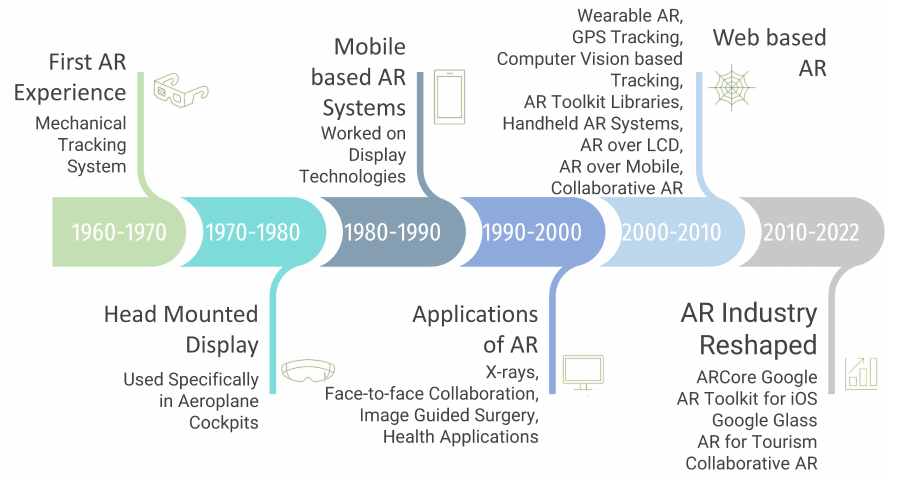
Figure 3. Augmented reality advancement over time for the last 60